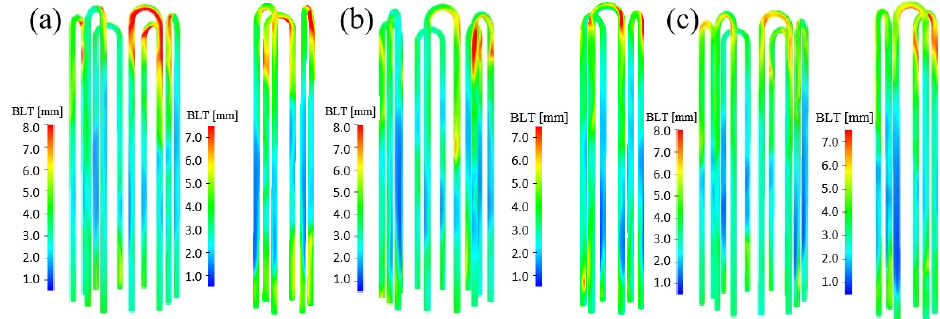
Figure 6. Flow field distribution. ( a ) Design A; ( b ) design B; ( c ) design C (height of horizontal sec- tions is the same as in Figure 4).